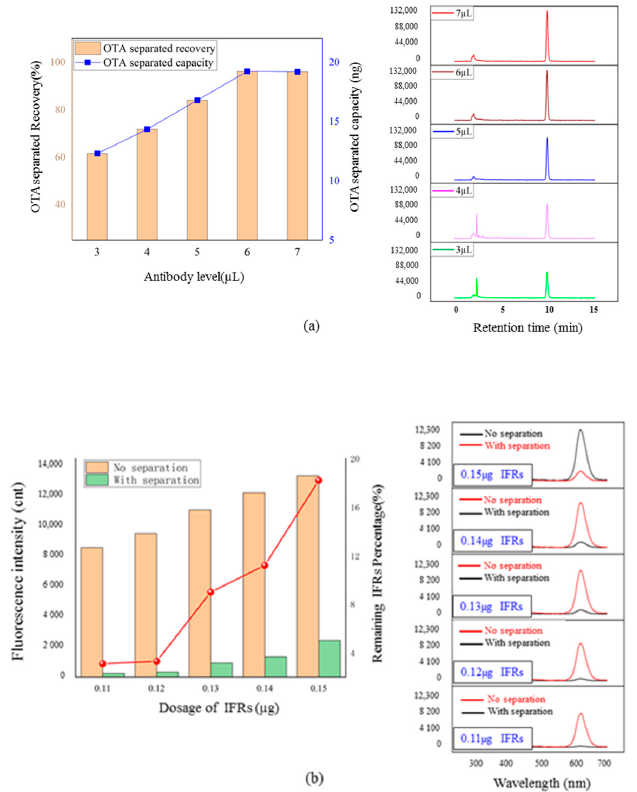
Figure 4. The optimization of IFRs dosage and antibody level for the immuno-separated assay. ( a ) Effects of antibody level on separated recovery for 20 ng of OTA. ( b )Separation effects of different dosages of IFRs by 6 µL of antibody solution